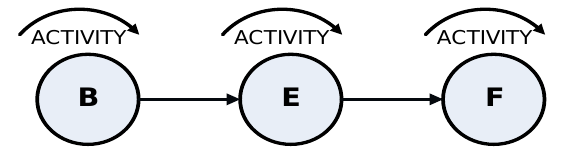
Figure 3. Simple precedence B precedence E, which precedence F. For Figure 2 :